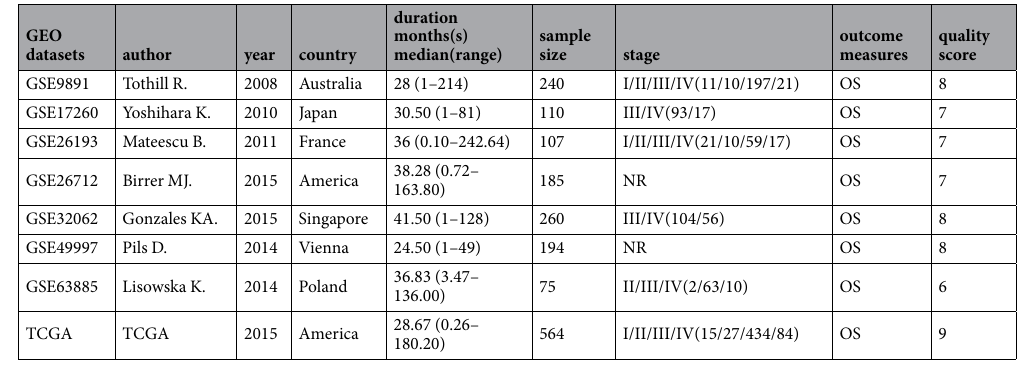
Table 1. Baseline Characteristics of 8 Microarray Data for Pooled-Analysis. NR = not report; OS = overall